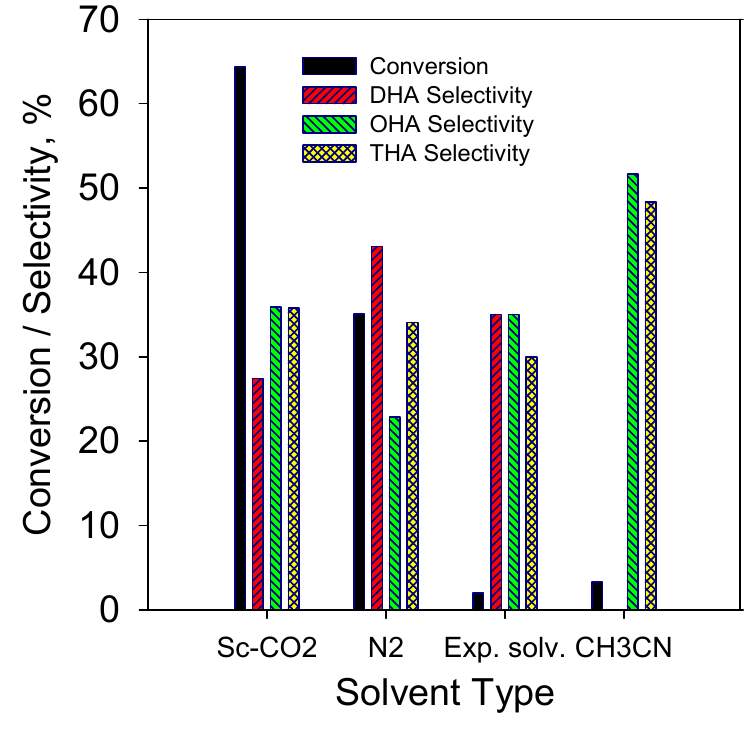
Figure 9. Effect of solvent on hydrogenation of anthracene over 10 wt.% Ni/H β -zeolite catalyst. Catalyst weight: 0.5 g; Reaction temperature: 100 °C; Reaction pressure: 6.9 MPa; H partial pressure: 2.76 MPa; volume of the reactor: 50 mL; reaction time: 6 2